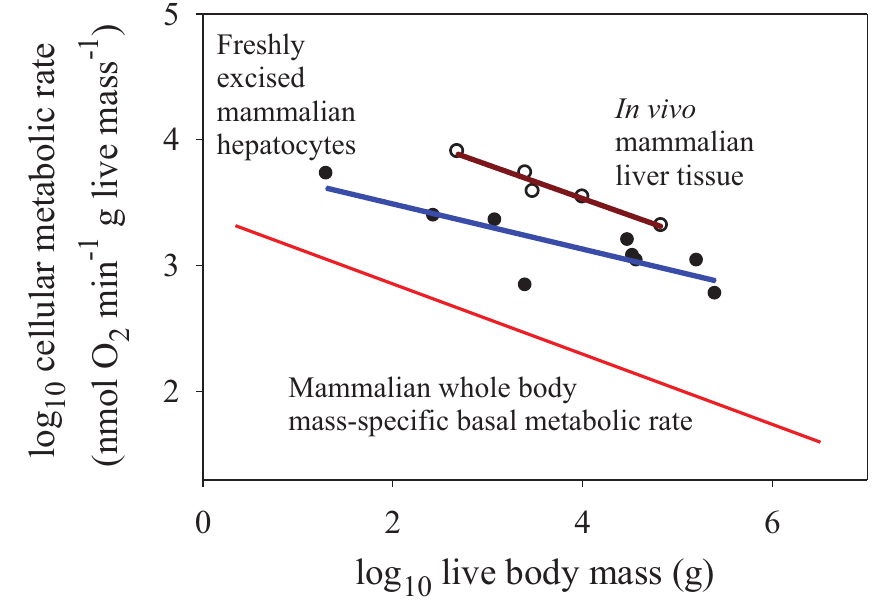
Figure 3. Scaling of log mass-specific metabolic rates of liver cells in vitro (for freshly excised cells: solid circles and blue line, Y = 3.85 − 0.179(X); r 2 = 0.679; p = 0.0063; N = 9; data from [14]) and in vivo (for intact liver tissue: open circles and red li ne, Y = 4.61 − 0.268(X) ; r 2 = 0.951; p = 0.0047; N = 5; data from [21]) with log body mass. For comparison, the mass-specific scaling of basal metabolic rate in mammals (from Figure 2) is also shown. Note that in vitro liver cells have significantly lower metabolic rates than those of in vivo liver cells (ANCOVA: F 1,11 = 25.45; p = 0.00037). The metabolic scaling slope for in vitro liver cells (−0.179 ± 0.110 95% confidence intervals (CI)) is also less steep than that for in vivo liver cells (−0.268 ± 0.1 12), but not significantly so (as seen by the overlapping CI). The scaling slope for in vivo liver cells is also not significantly different from that for whole body mass- specific basal metabolic rate (−0.279 ±